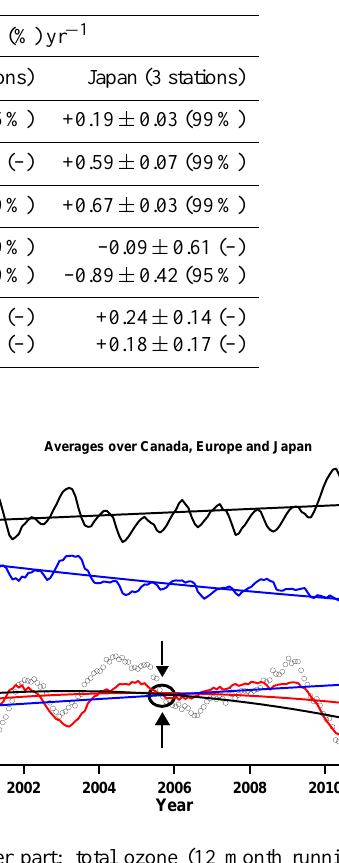
mates a − 1.5 % to − 2 % UV-B decrease from 2007 to